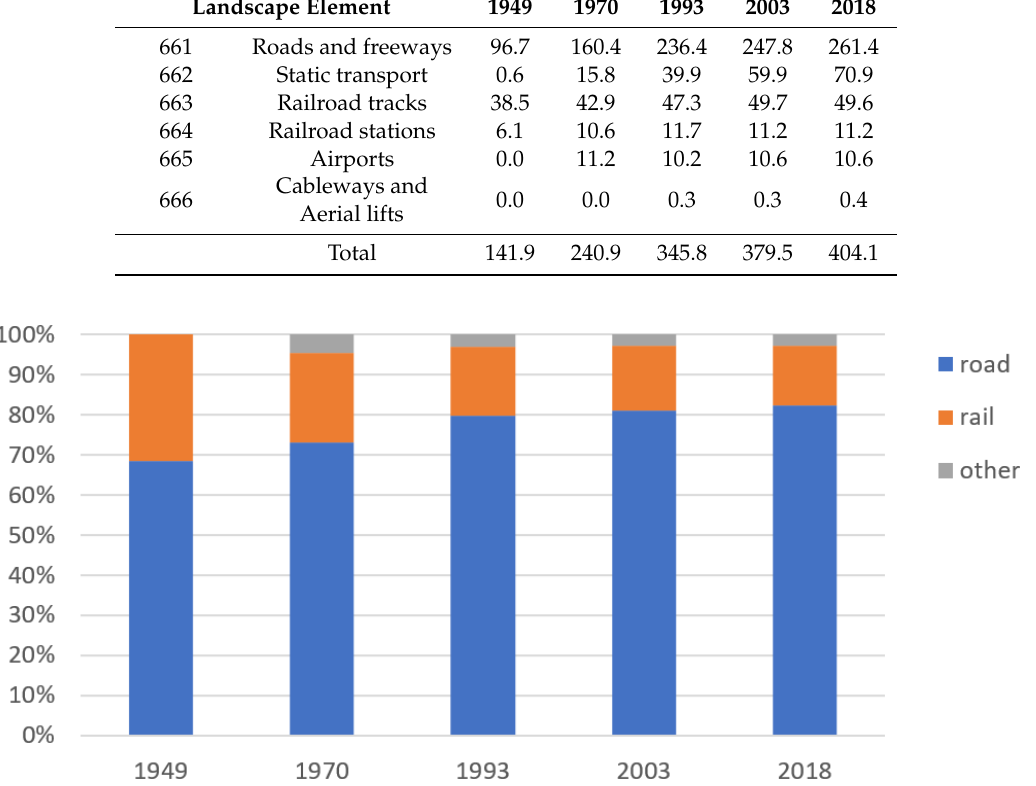
Figure 3. The shares of various transportation modes in the area of landscape elements in the category Transport related objects and areas.